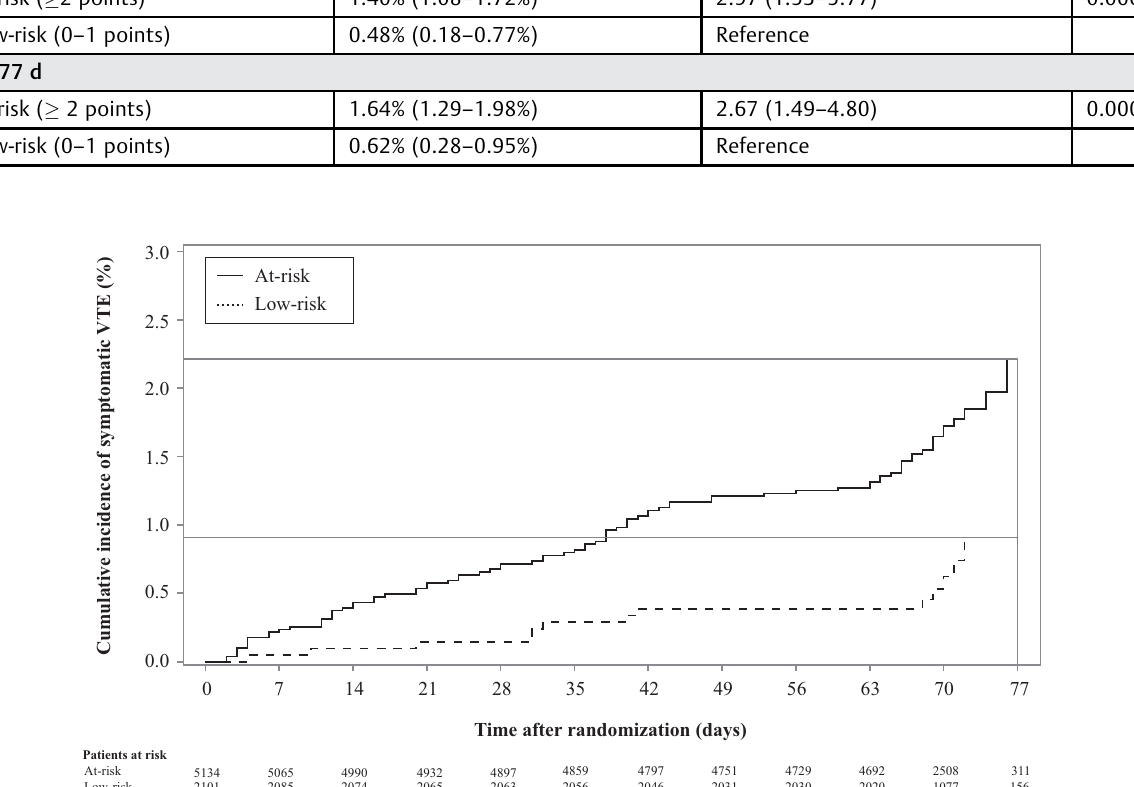
Fig. 3 Kaplan – Meier curves for symptomatic VTE strati fi ed by the IMPROVEDD risk category.